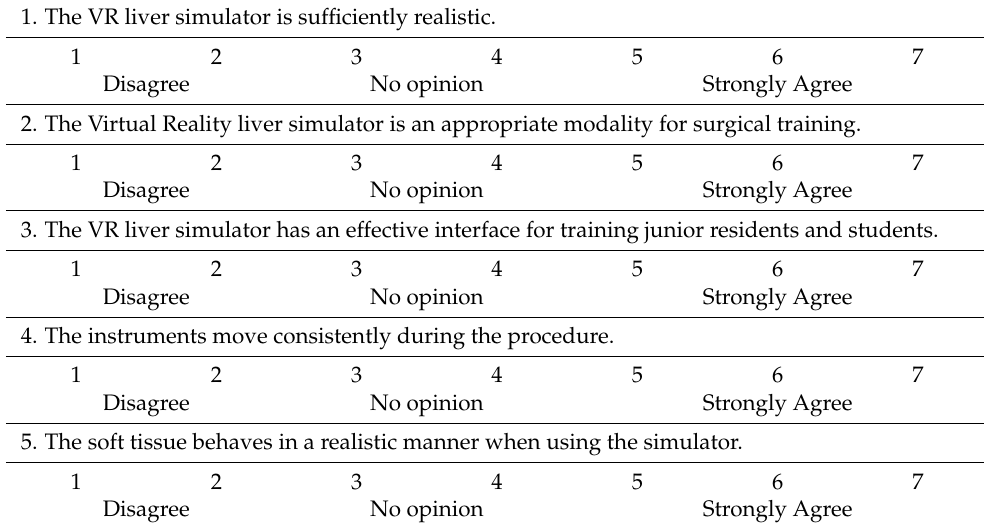
Table 2. Post-simulation